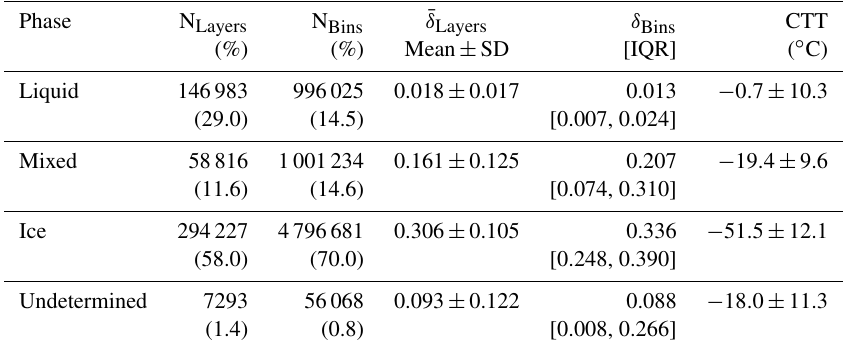
Table 3. Cloud-phase properties for GSFC, 2018–2019. Number of layers ( N Layers ) and altitude bins within each layer ( N Bins ) , mean layer- integrated LDR ( ¯ δ Layers ), median LDR ( δ Bins ), and interquartile range (IQR) for all altitude bins within each layer, and the mean cloud top temperature